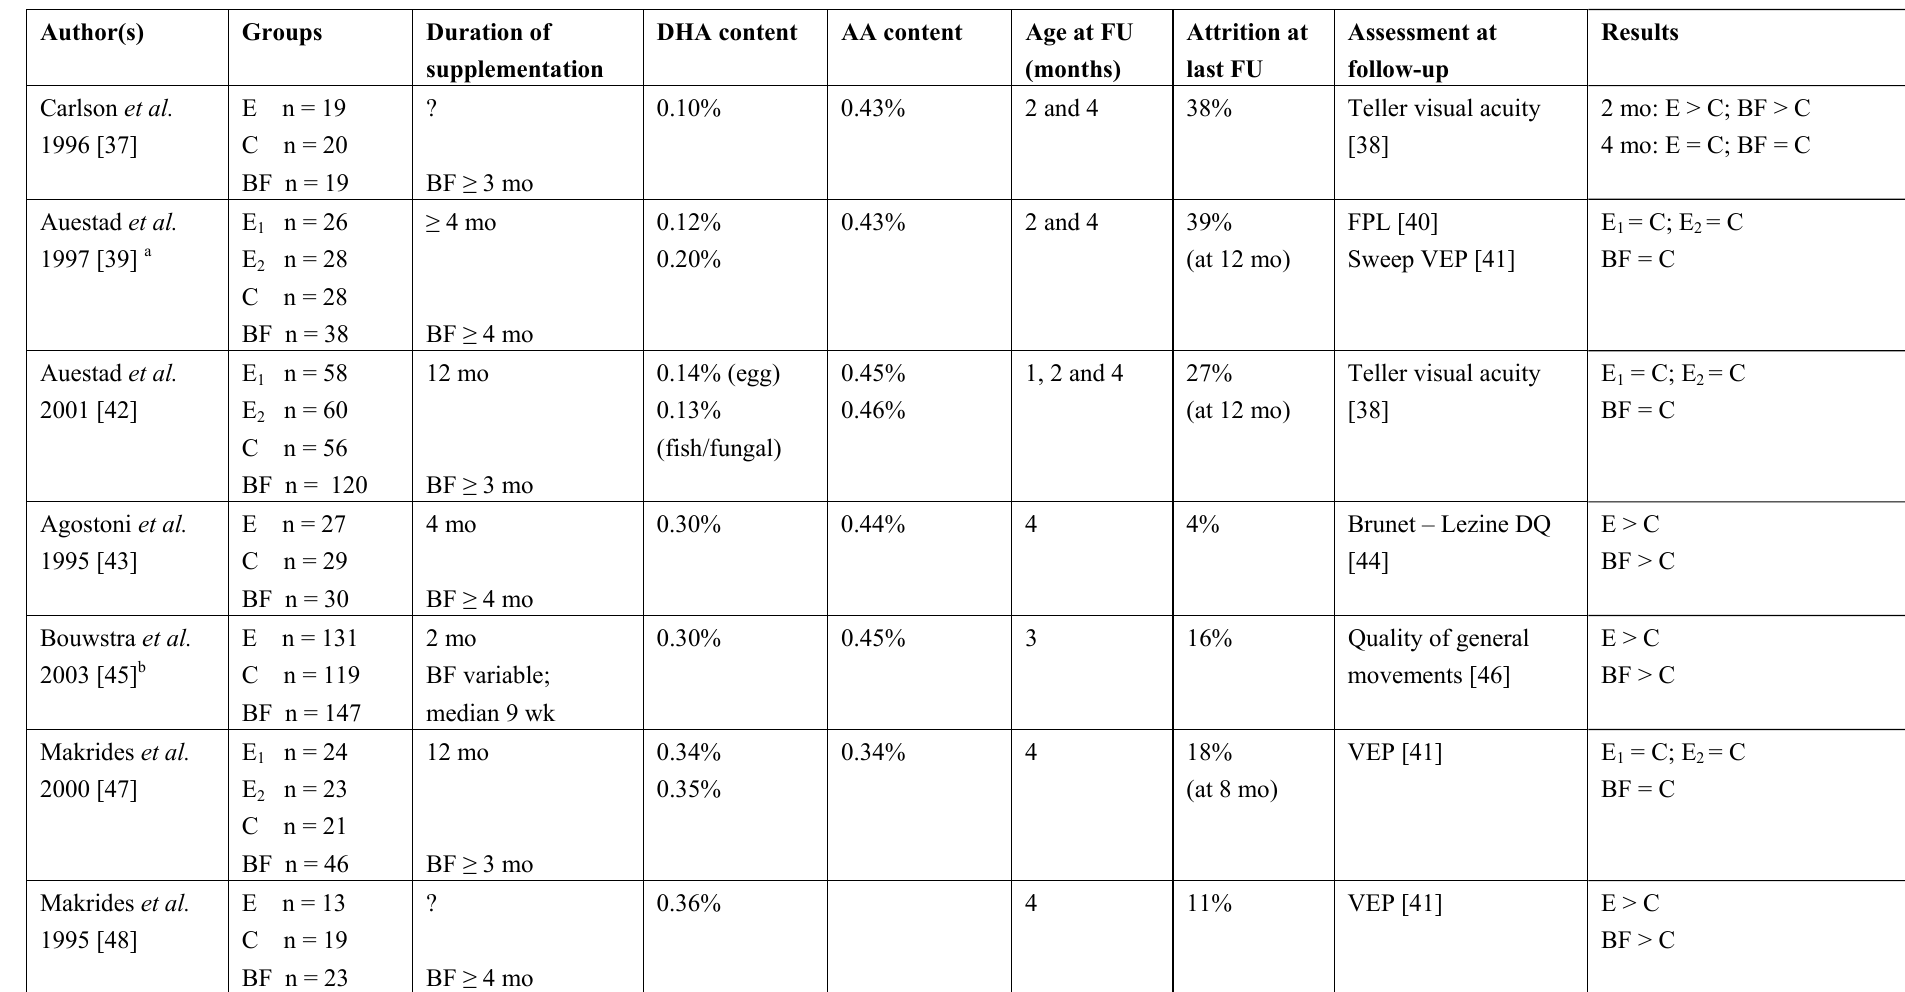
Table 1. LCPUFA supplementation in term infants and outcome until four months of age (adapted and updated from Hadders-Algra 2005